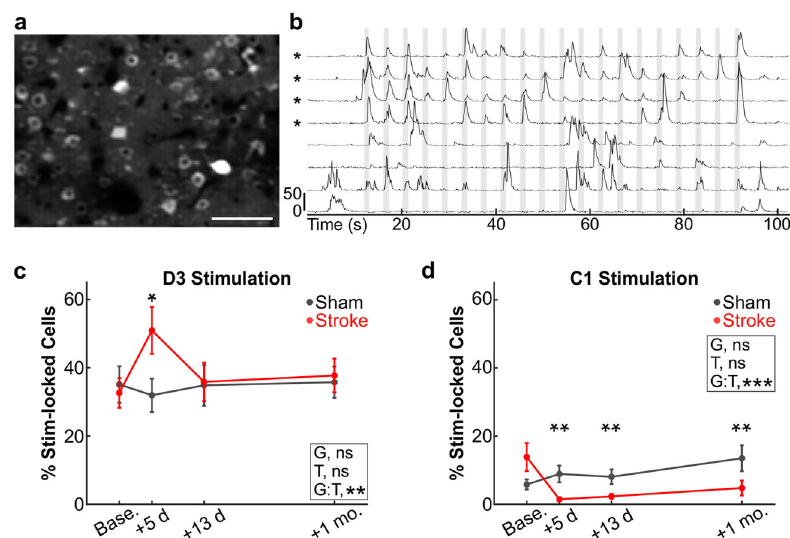
Fig. 2 No increase in the percentage of C1 whisker-responsive neurons in peri-infarct cortex after C1-targeted stroke. a Maximum intensity projection image (representative across all 15 animals imaged in this experiment) of GCaMP6s fl uorescence in the D3 barrel of a Thy1-GCaMP6s mouse, before stroke. Scale bar = 100 μ m. b Representative traces of GCaMP6s fl uorescence signal intensity from four stimulus-locked (indicated with asterisks) and four non-stimulus-locked L2/3 neurons in response to whisker stimulation (10 Hz). Scale bar indicates Z -score change of 50. Vertical gray bars indicate epochs of whisker stimulation (1 s long, 3 s interstimulus interval). c Percentage of L2/3 neurons in the D3 barrel showing responses that were stimulus-locked to D3 whisker stimulation for mice that received a sham procedure (gray) or a photothrombotic stroke (red) to the C1 barrel. Individual timepoints are means ± s.e.m. GLME binomial model, ANOVA for fi xed effects of group (G, p = 0.736), timepoint (T, p = 0.803), and group-by-timepoint interaction (G:T, ** p = 0.009) are indicated on the respective plots. d Percentage of L2/3 neurons in the D3 barrel showing responses that were stimulus-locked to C1 whisker stimulation. GLME binomial model, ANOVA for fi xed effects of group (G, p = 0.154), timepoint (T, p = 0.236), and group-by-timepoint interaction (G:T, *** p < 0.001) are indicated on the respective plots. Data in c and d represent mean ± s.e.m. N = 6 and 9 mice for sham (gray) and stroke (red), respectively, except n = 8 for stroke mice at + 13 days in d and n = 6 for stroke mice at + 1 month in c and d . Signi fi cance for individual coef fi cients for G:T, corrected using Benjamini and Hochberg ’ s method, are indicated over corresponding data points (* p < 0.05; ** p <